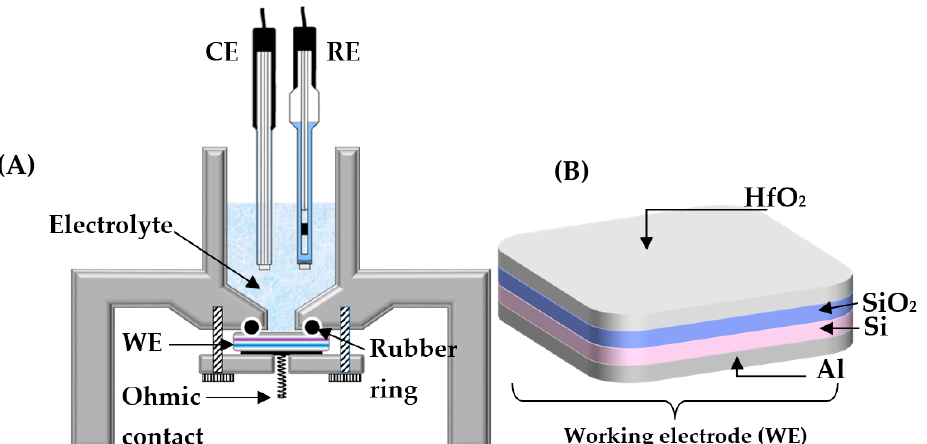
Figure 1. ( A ) Electrochemical cell used for pH measurement with Calomel-Saturated Reference electrode (RE), counter electrode (CE), and Ohmic contact behind the WE; ( B ) working electrode with electrolytic-insulating-semiconductor structure based on Al/Si/SiO 2 /HfO 2 .